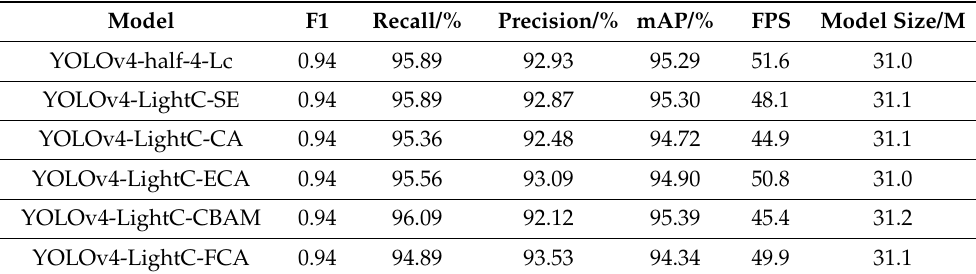
Table 4. Comparison table of attention